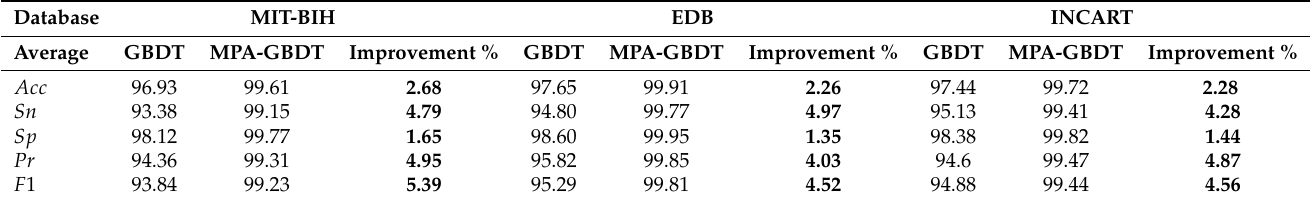
Table 9. The performance comparison of the GBDT and its optimized version, the MPA-GBDT.